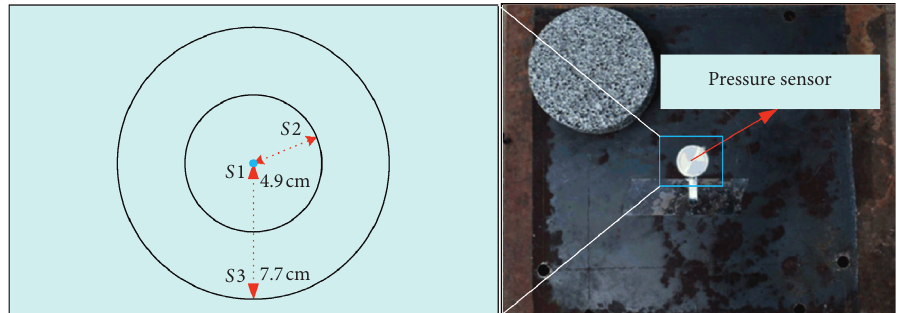
Figure 6: Sensor